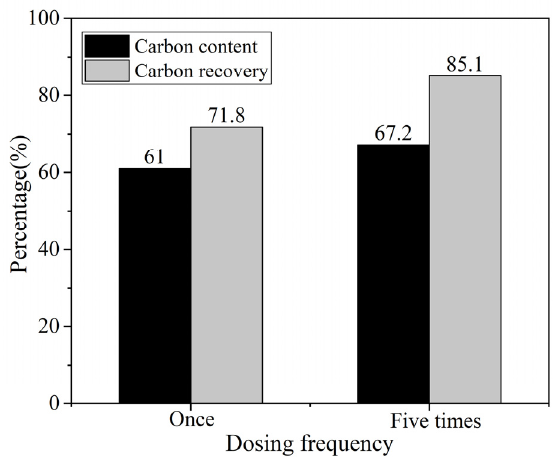
Figure 11. Effect of batch addition on flotation.